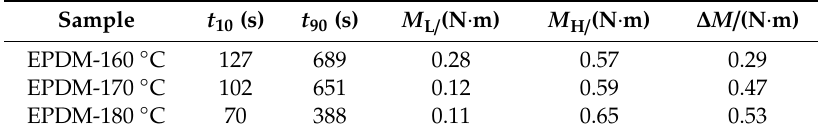
Table 2. Curing characteristics of pure EPDM at di ff erent temperatures.